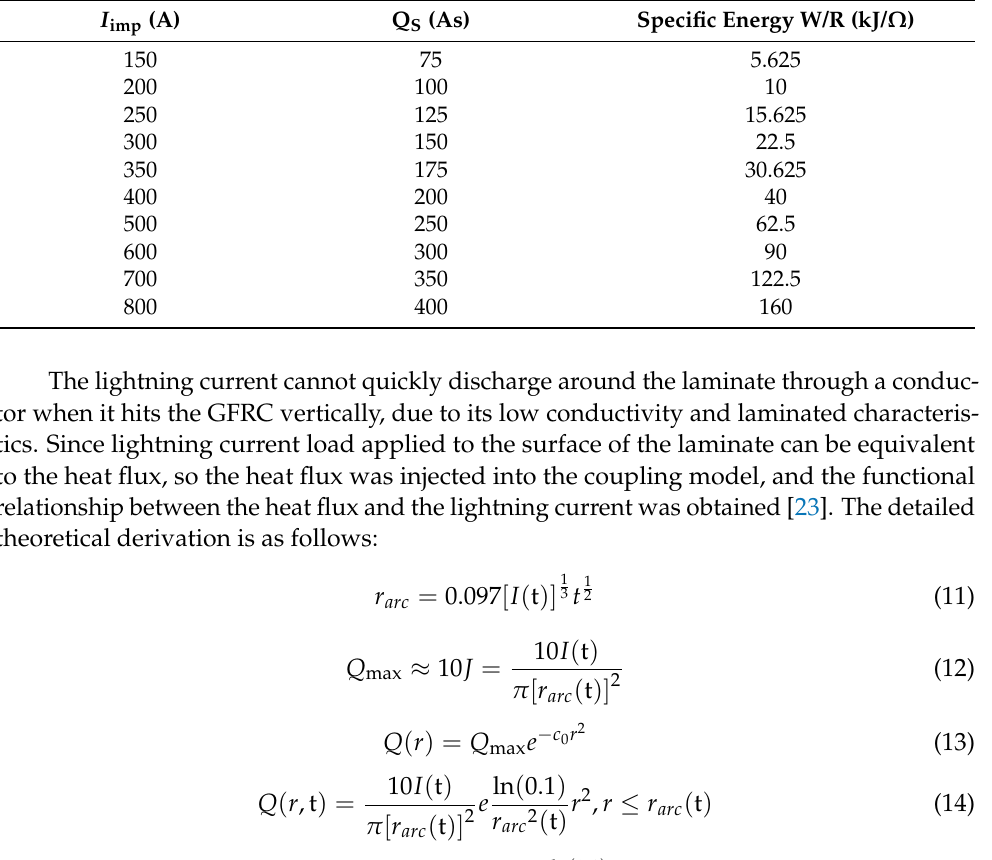
Figure 8. Loading and boundary conditions of through-thickness ablation damage modelling. Table 2. Simulation experiment lightning current C component parameter.